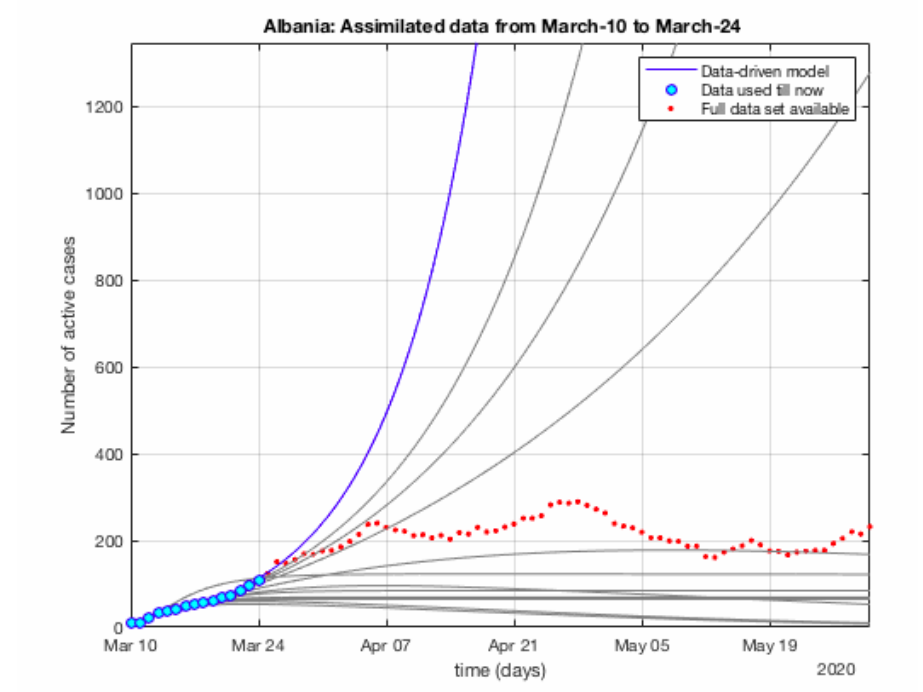
evolution of the epidemiological ODE with 17 states connection with SIR Figure 9 connection with SEIR Figure 10 connection with SIRD Figure 11 connection with SEIRD Figure 2 pandemic vs. economic consequences of COVID-19 Figure 12 spread worldwide Figure 13 propagation of the virus in 15 most reported active cases Figure 14 G7 countries Figure 15 New York and Los Angeles testing results: data vs. model Figure 18 Brazil: Sequential data-driven model Figure 19 USA: Sequential data-driven